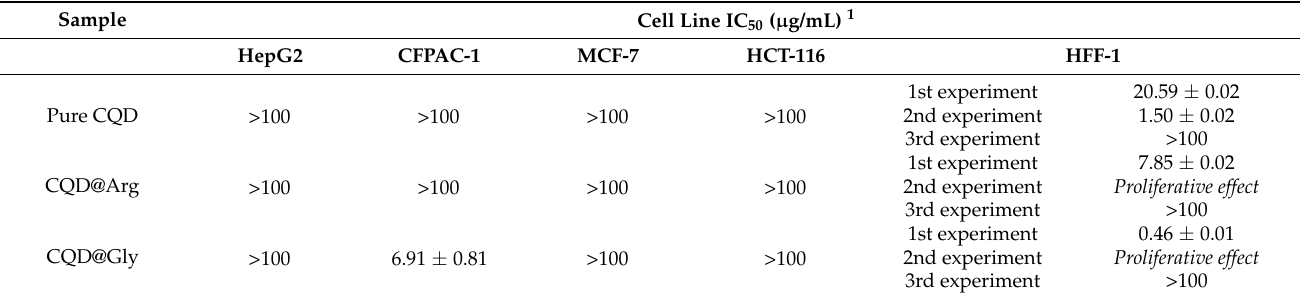
Table 1. Antiproliferative activity in vitro for samples of pure CQD, CQD@Arg, and CQD@Gly presented as IC 50 values ( µ g/mL) ± standard deviation. Results from experiments carried out on human fibroblasts HFF-1 are presented for each biological replicate separately, while results for tumour cell lines are presented as means from three consecutive experiments.